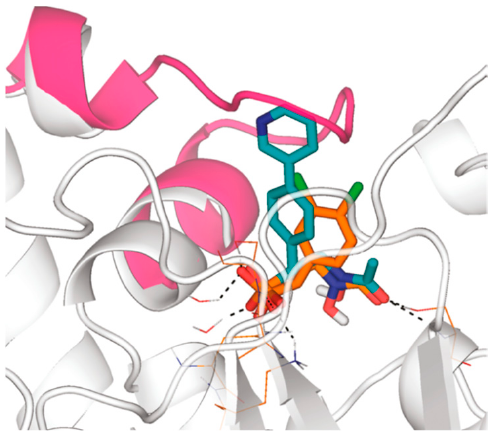
Figure 19. Compound 89 (turquoise carbon atoms) docked in the X-ray structure of Mt DXR in complex with 3 orange carbon atoms (PDB code 2Y1G) [128]. The Gly198-Met208 flap (colored in pink) from the 2JVC structure representing Mt DXR bound to fosmidomycin ( 1 ). Reprinted with permission from J. Org. Chem. 2011, 76, 21, 8986–8998 [129]. Copyright 2022 American Chemical Society.